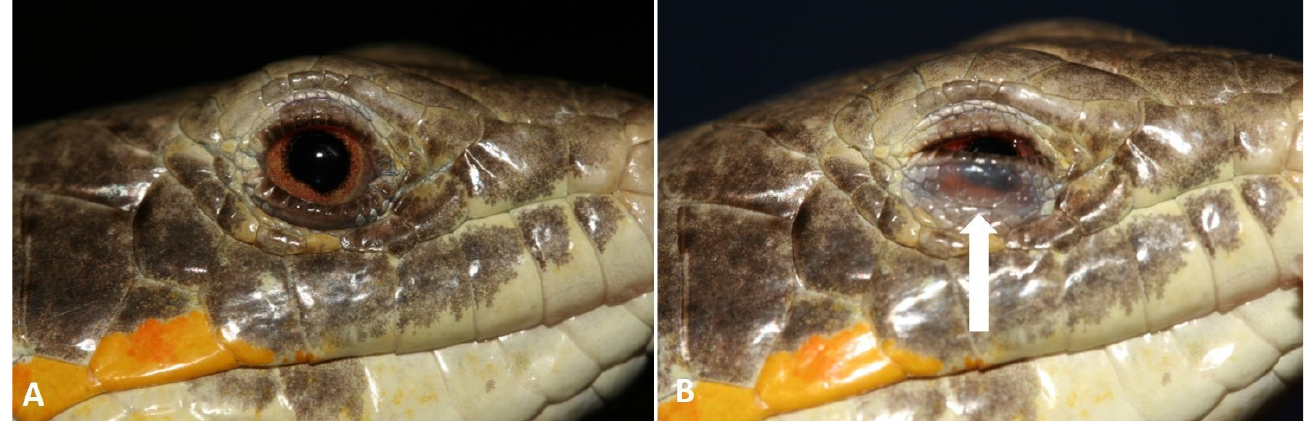
Figure 1. ( A ) Schneider’s skink ( Eumeces schneiderii ); this species has a window in the lower eyelid (arrow) made up by multiple transparent scales ( B ). Table 1. Overview of squamate lineages that show a varying degree of modification of the eyelids or possess a truly transparent and rigid spectacle.